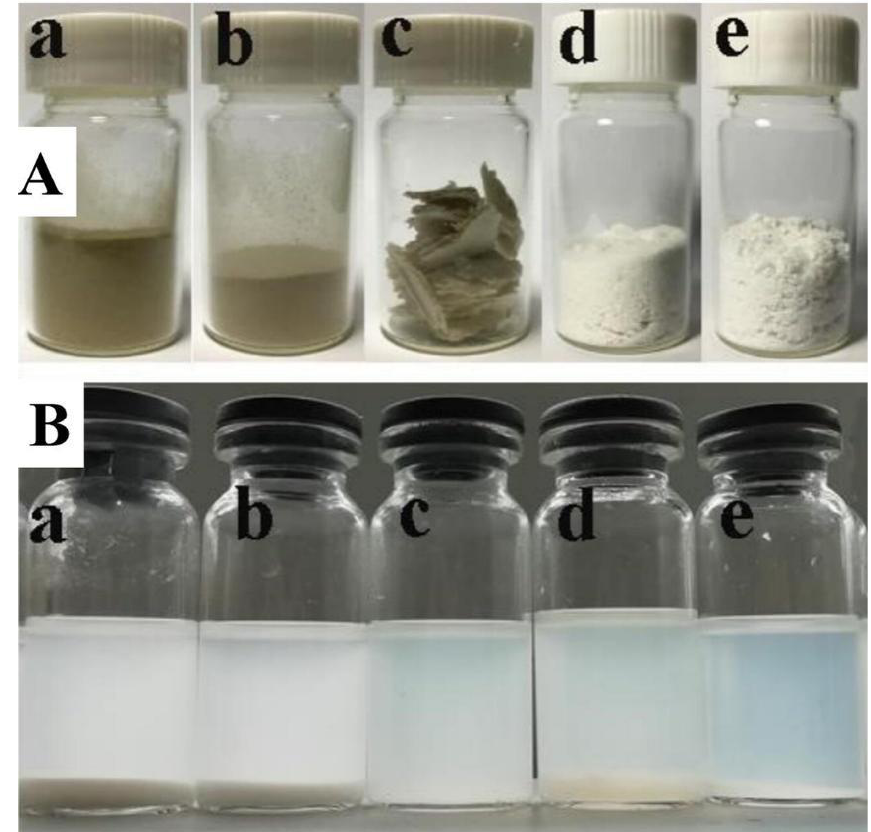
Figure 8. ( A ) Photographs of products from rice straw to RSCA at different stages: (a) rice straw powder, (b) pretreated rice straw, (c) rice straw-derived coarse cellulose (d) RSC, (e) RSCA. ( B ) Photographs showing the solubility property of RSCA with different DS: (a) DS = 0.51, (b) DS = 0.75, (c) DS = 1.12, (d) DS = 2.75, (e) DS = 2.82.